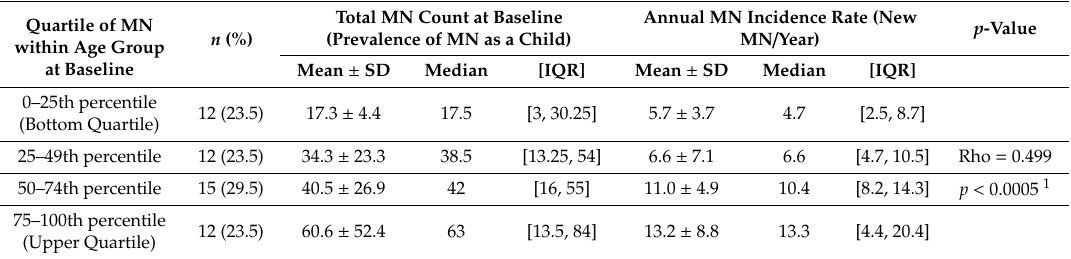
Table 3. Annual rate of acquisition of new melanocytic nevi (MN) acquired since baseline shown by total MN prevalence (expressed as quartiles) at baseline.